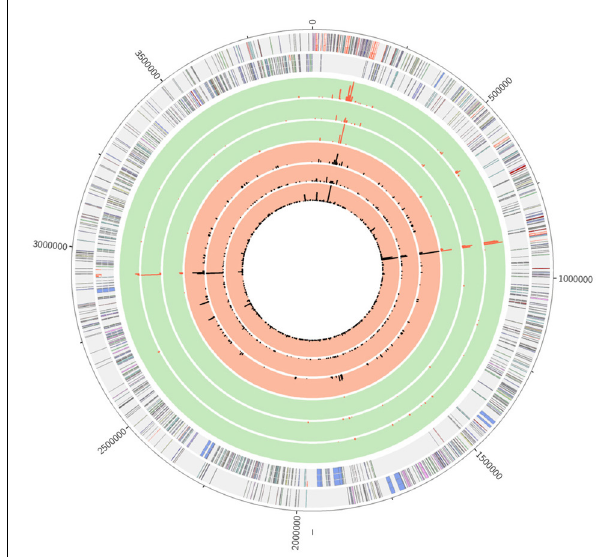
FIGURE 2 | Mapping of metagenome sequence reads to the B. amyloliquefaciens FZB42 genome. The circles represent from inner to outer most: (i) t0 inoculated sample; (ii) t1 inoculated sample; (iii) t2 inoculated sample; (iv) t0 control; (v) t1 control; (vi) t2 control; (vii) annotated coding sequences in both strands; (viii) scale in bp. The replication initiation gene dnaA was chosen as first gene of the chromosome. Coding sequences are colorized depending on their gene function according to COG (Clusters of Orthologous Groups of proteins) categories. The scale for mapped reads represents the relative abundance of reads per base normalized to the maximum value of mapped reads per base.